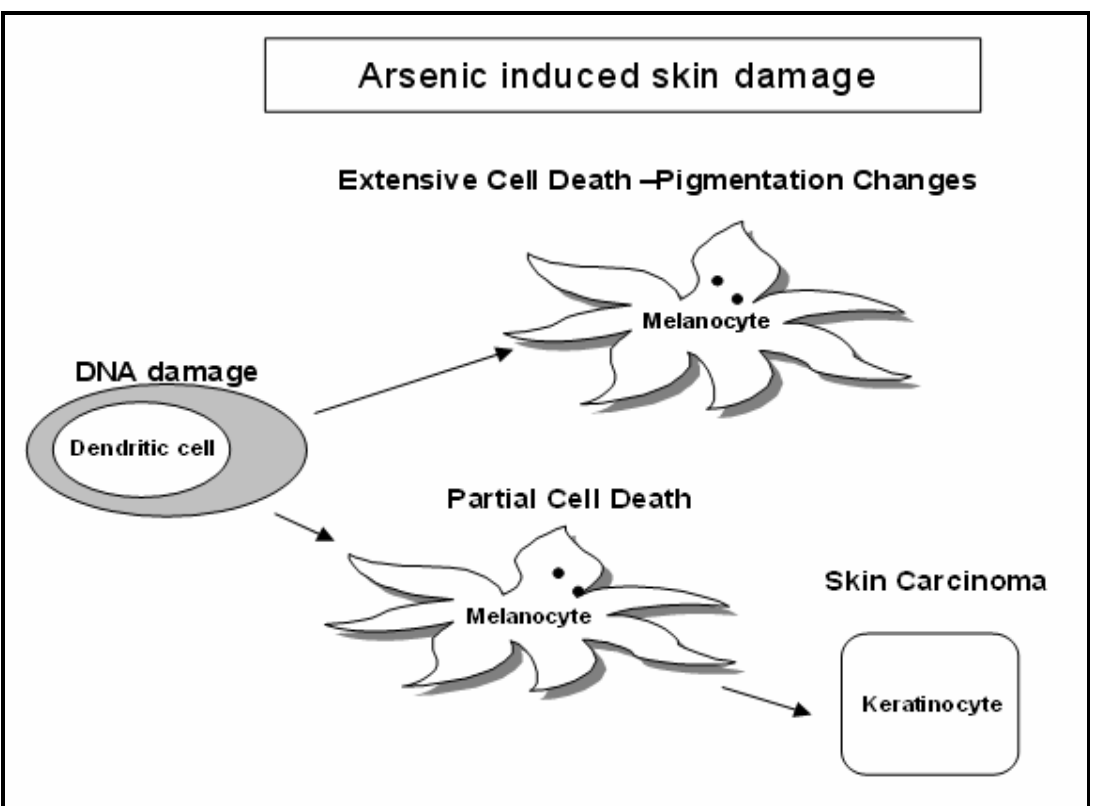
Figure 3 : A schematic representation of the damage caused by arsenic on the cellular elements of the skin involving keratinocytes, melanocytes and dendritic